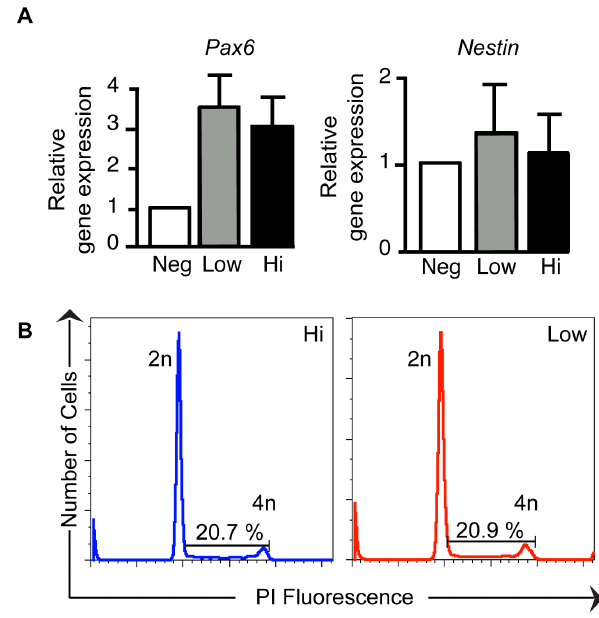
Figure 6. Differentiated h Fezf2 -YFP cells at day 30 share similar cell cycle kinetics. ( A ) Quantitative RT-PCR analysis of progenitor markers, Pax6 and Nestin , on differentiated and sorted cells at day 30. ( B ) Flow cytometry analysis of cell cycle properties of differentiated and sorted h Fezf2 -YFP cells. The cells were stained with propidium iodide to reveal DNA content. Abbreviation: PI, propidium iodide.